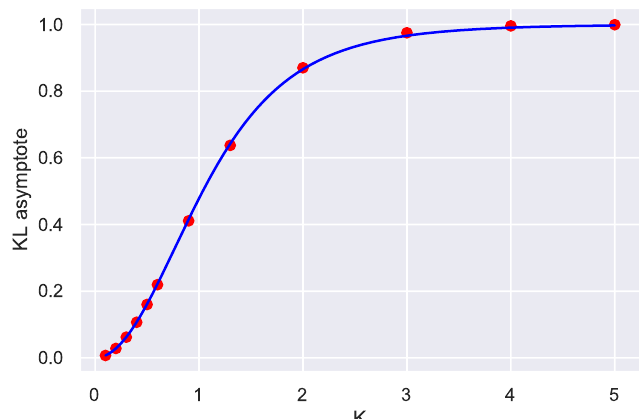
Figure 2: The asymptote of the normalized relative entropy of the 1d classical Ising model as a function of the nearest-neighbor interaction coupling constant K (red dots). The solid line is the fit function